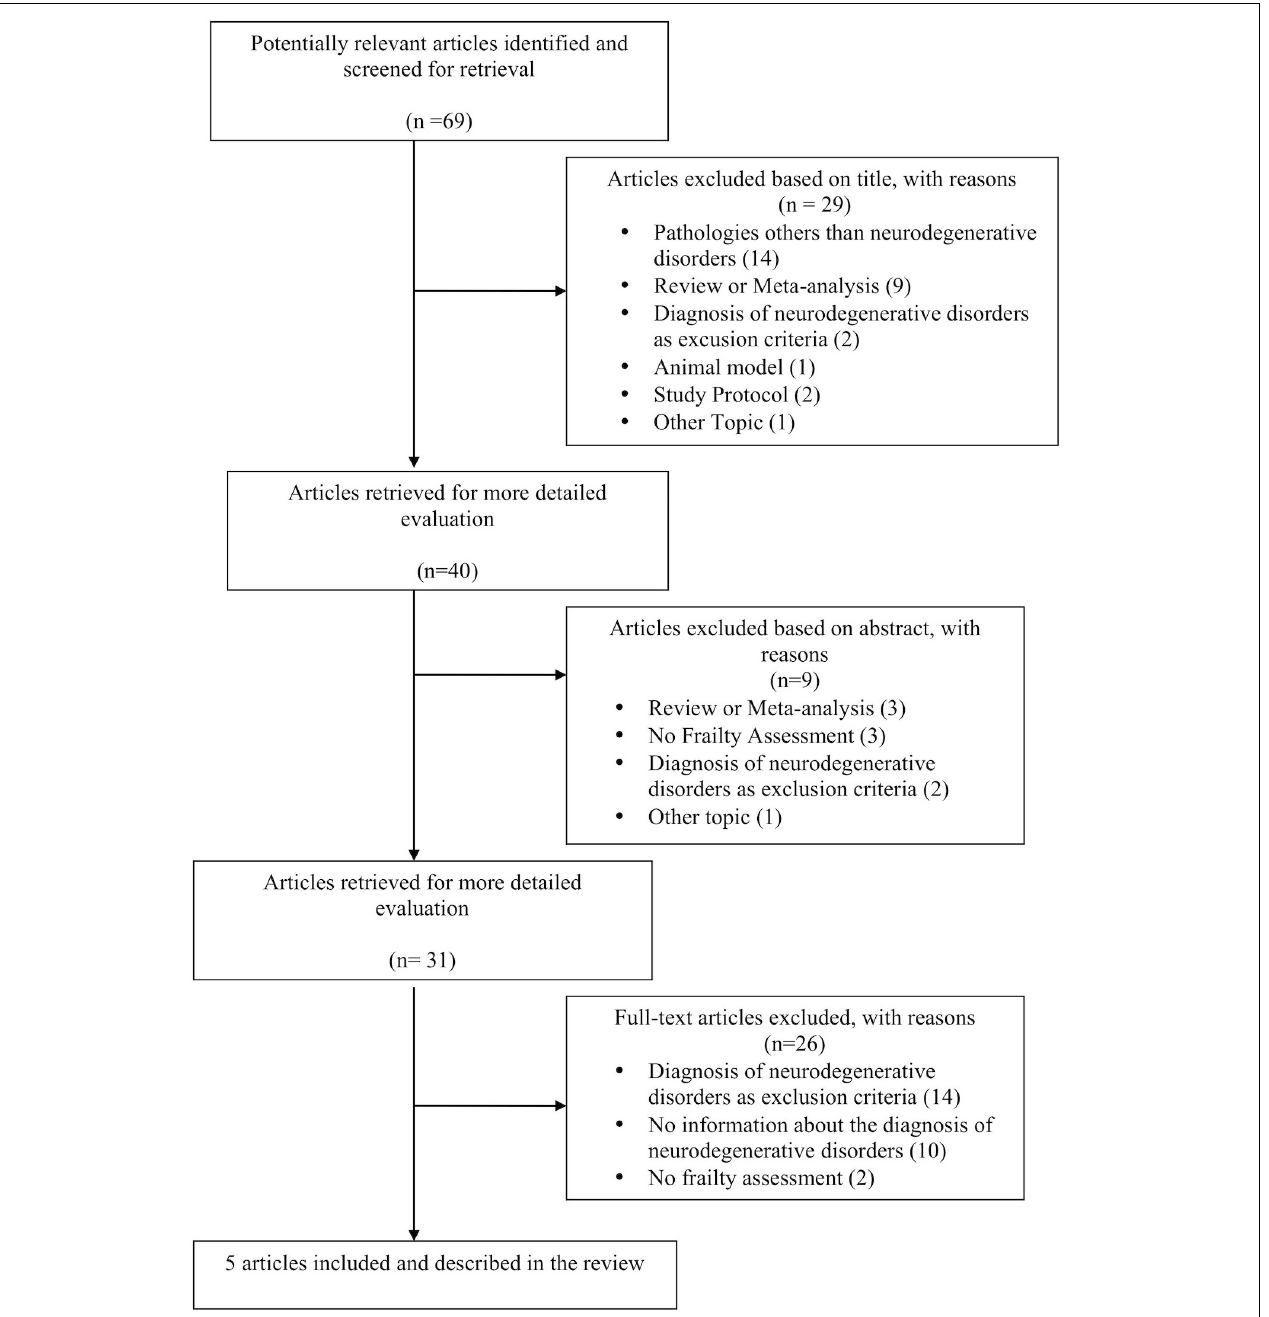
FIGURE 2 | Article selection flow chart according to the PRISMA